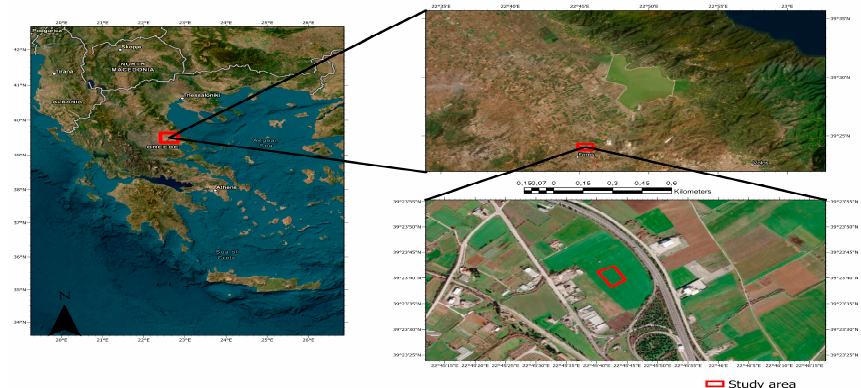
Figure 2. Location of the study area.